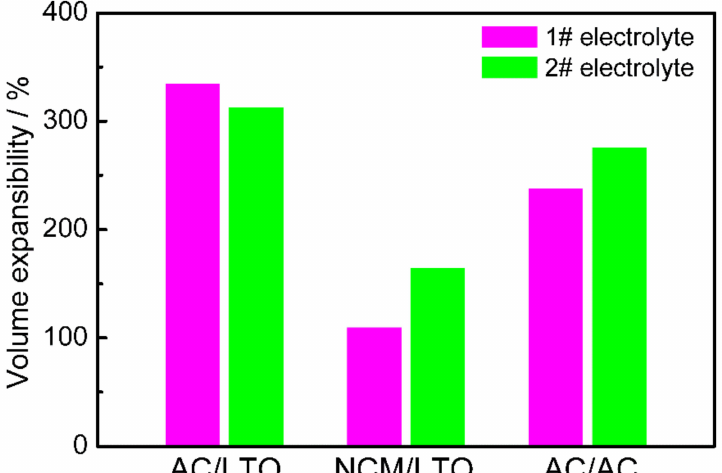
Figure 7. The volume expansibility of AC/LTO, NCM/LTO and AC/AC devices after storage at room